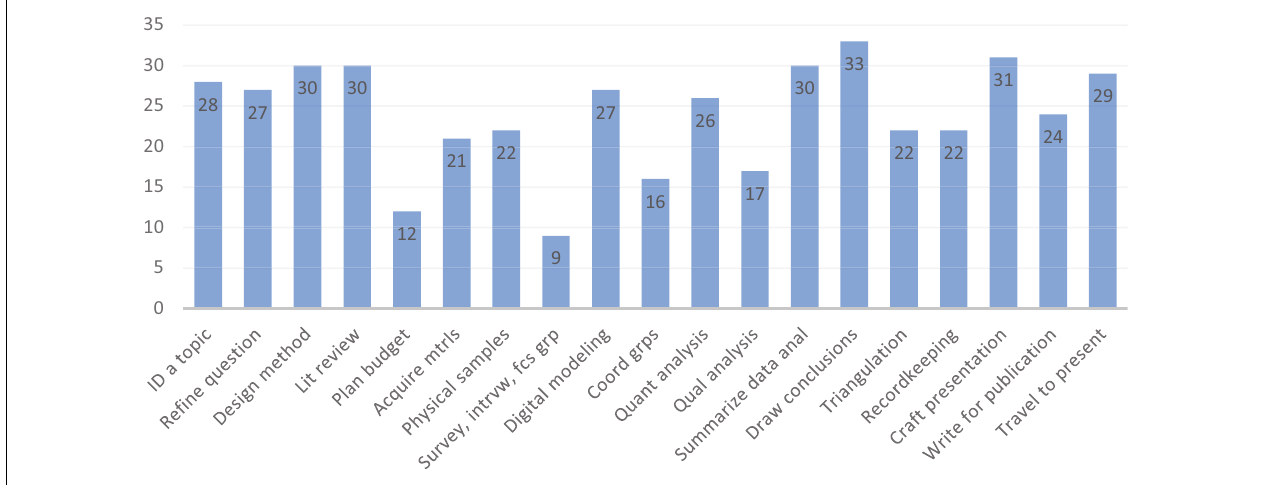
FIGURE 2 | Response counts for elements of research experienced in undergraduate research. TABLE 2 | Grouping of research experiences by response rate. Reported by 26 or more